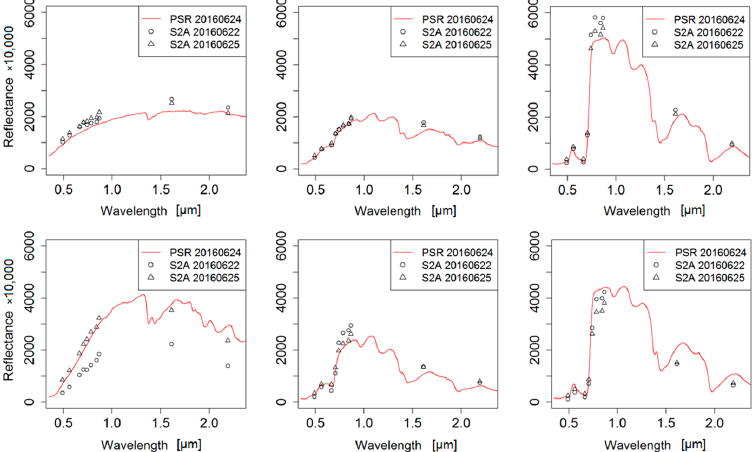
Figure 8. Comparison between field spectral measurements on 24 June and Sentinel-2 data acquired on 22 June and 25 June 2016 over an agricultural region East of Vienna, Austria (Sentinel-2 tile 33UXP) from upper left to lower right: bare soil, winter wheat 1, potato, harvested field, winter wheat 2, and soya. Reflectance values are scaled by 10,000.